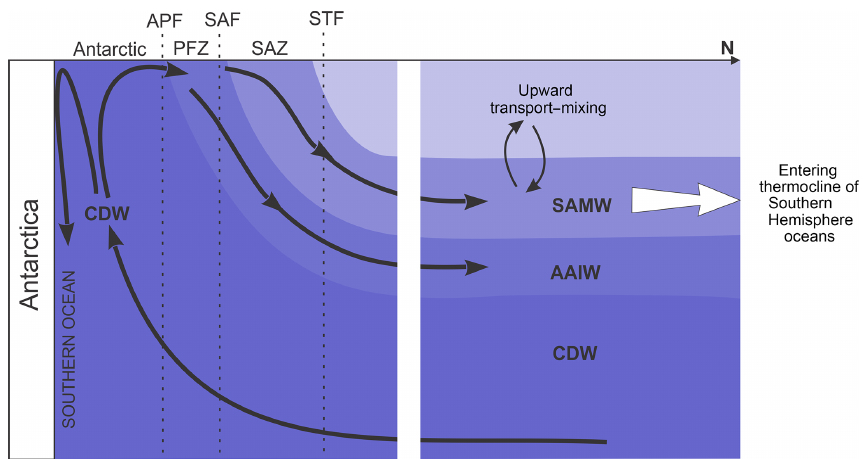
Figure 2. Schematic representation of ventilation and subduction of water masses in the Southern Ocean (modified after Anderson et al., 2009). Wind-driven upwelling south of the latitude of maximum westerlies brings Circumpolar Deep Water (CDW) to the surface and contributes to Antarctic Surface Waters. Antarctic Surface Waters represent the dominant source of the upper and intermediate waters that leave the Southern Ocean. Antarctic Intermediate Water (AAIW) originates from subduction of cold and fresh Antarctic Surface Waters across the Antarctic Polar Front (APF) and enters the South Atlantic mainly via the subtropical gyre. Subantarctic Mode Water (SAMW) originates from deep winter convection north of the Subantarctic Front (SAF). A low-density type of SAMW enters the thermocline of the Southern Hemisphere oceans along the southern edge of the subtropical gyres where it becomes part of central waters and contributes to ventilating the thermocline, while a denser type of SAMW formed in the eastern South Pacific is regarded as a precursor of the AAIW. The Polar Front Zone (PFZ) and Subantarctic Zone (SAZ) are the regions between the APF and SAF and between the SAF and Subtropical Front (STF)